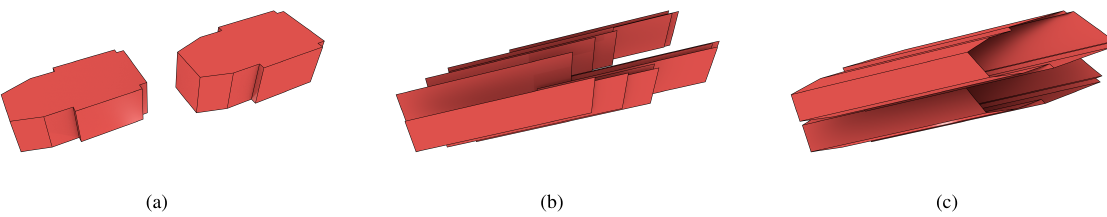
Figure 6: The polyhedron in Figure 3 can be extruded to 4D using the algorithm in Arroyo Ohori et al. (2015a). The result is a single polychoron, whose faces are shown here in parts for clarity: (a) the faces in the two end volumes, (b) the lateral faces connecting corresponding vertical edges, and (c) the top and bottom faces connecting corresponding horizontal edges. Not shown here are the 16 polyhedra that are formed from these